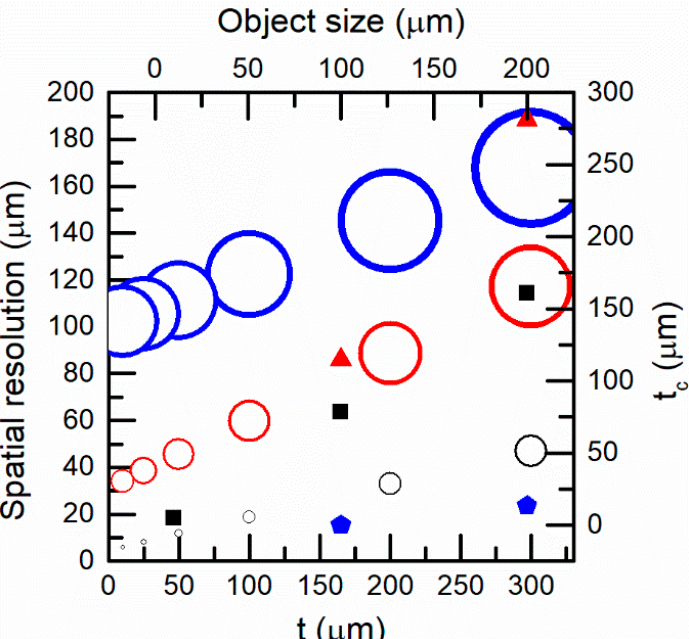
Figure 8. Left y-axis and bottom x-axis: spatial resolution as a function of the target-fiber distance for three different optical fibers (core diameter/NA): black: 9 μ m/0.14, red: 62.5 μ m/0.275, blue: 200 μ m/0.2. Right y-axis and top x-axis: t c as a function of the object size for those fibers: black squares: 9 μ m/0.14, red triangles: 62.5 μ m/0.275, blue pentagons: 200 μ m/0.2.